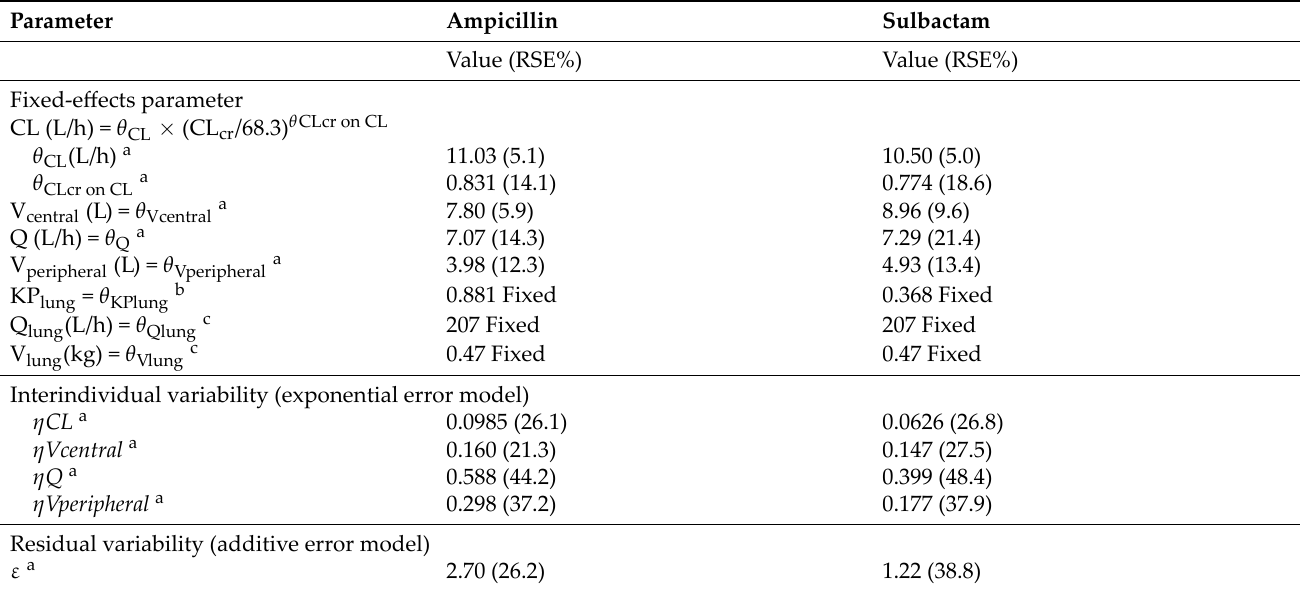
Table 4. PK parameters predicting lung tissue